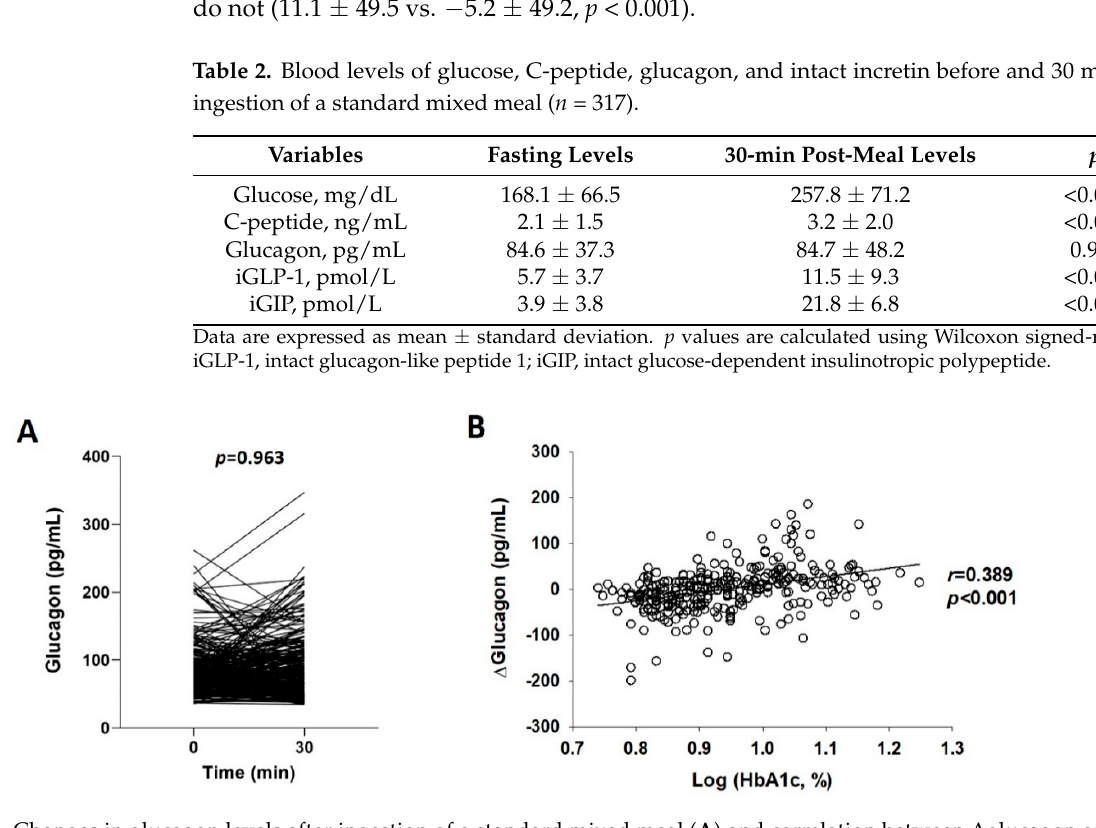
Figure 1. Changes in glucagon levels after ingestion of a standard mixed meal ( A ) and correlation between ∆ glucagon and HbA1c levels ( B ). HbA1c levels were logarithmically transformed. p values are calculated using the Wilcoxon signed-rank test ( A ) and r and p values are calculated using the Pearson’s correlation analysis ( B ). r, correlation coefficient; ∆ Glucagon, (30-min postprandial glucagon level)—(basal glucagon level).